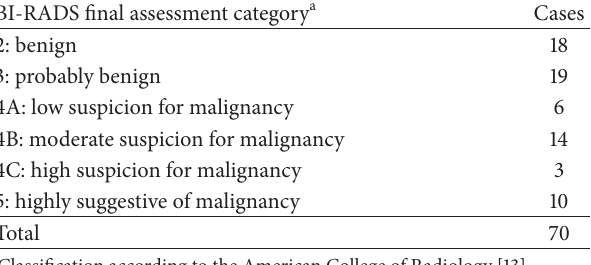
Table 1: Distribution of cases in the sample according to the BI- RADS final assessment categories.